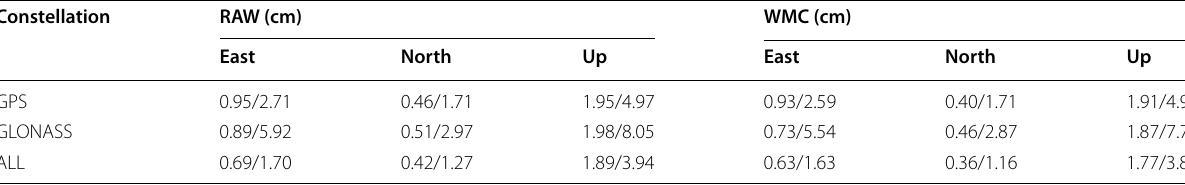
Table 6 Average RMS of static/kinematic positioning errors for global stations using combined orbits and clocks